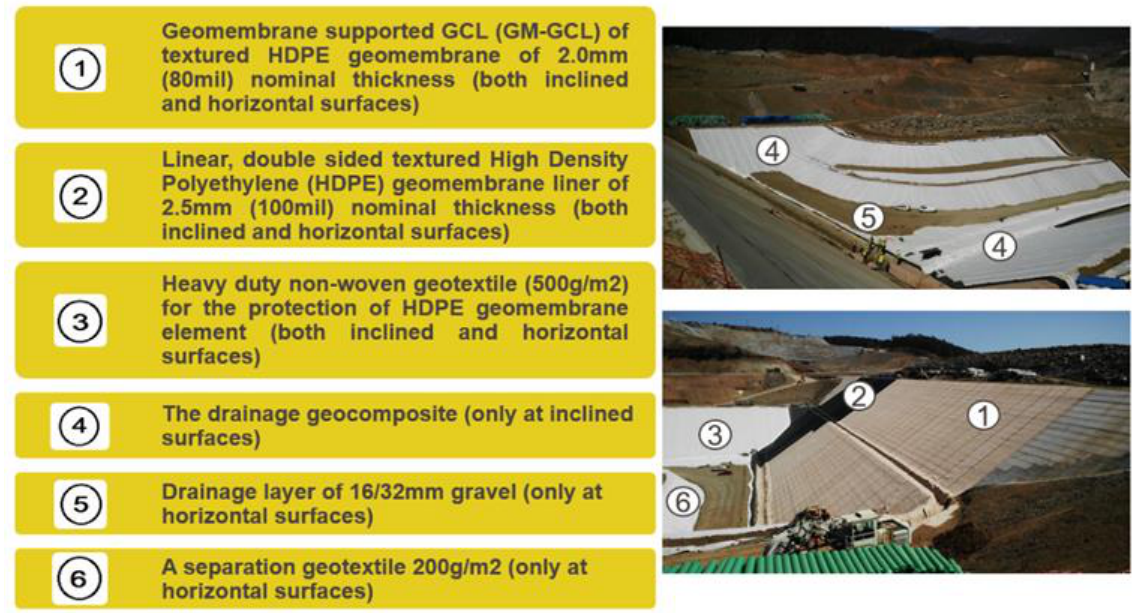
Figure 5. Description and installation of the composite lining system.